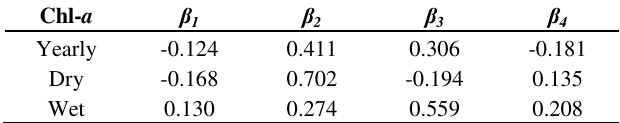
Table 4. Standardized regression coefficient values for Chl- a